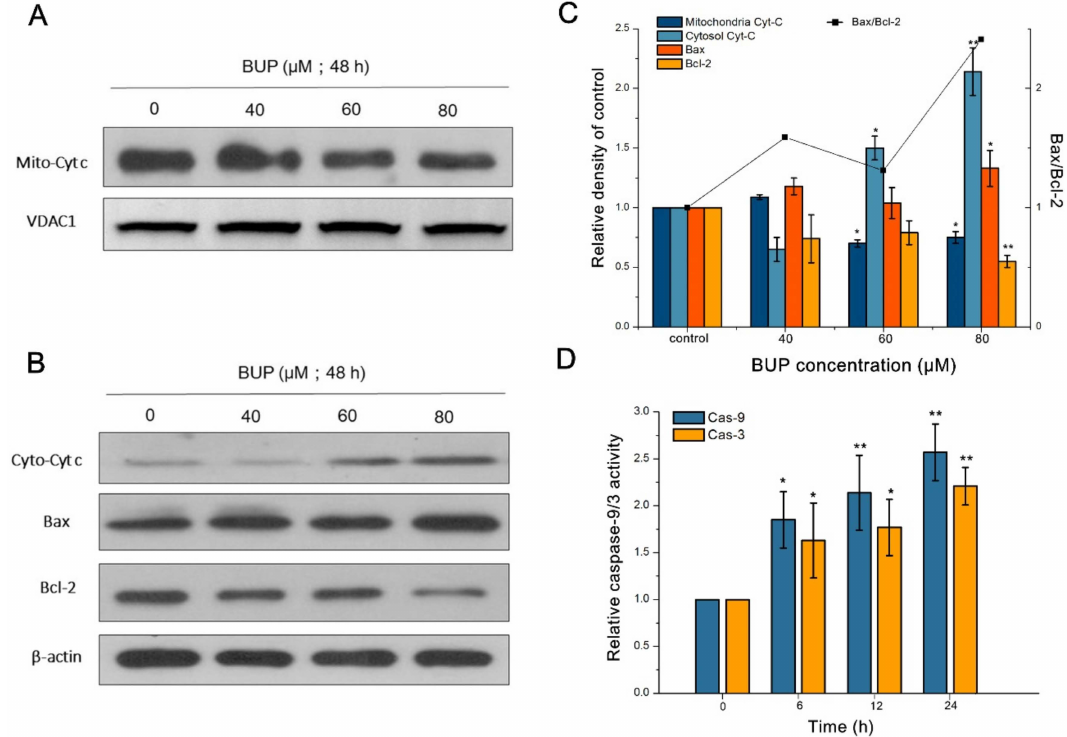
Figure 3. Investigation of apoptotic protein expression in A549 cells after exposure to BUP at different concentrations and for various time intervals, showing: ( A , B ) results of cyt-c distribution, Bcl-2, and Bax in A549 cells by western blot, ( C ) intensity of Bax/Bcl-2 and cyt-c ratio, and ( D ) activity of caspase-3 and -9. * p ≤ 0.05 and ** p ≤ 0.01 vs. negative